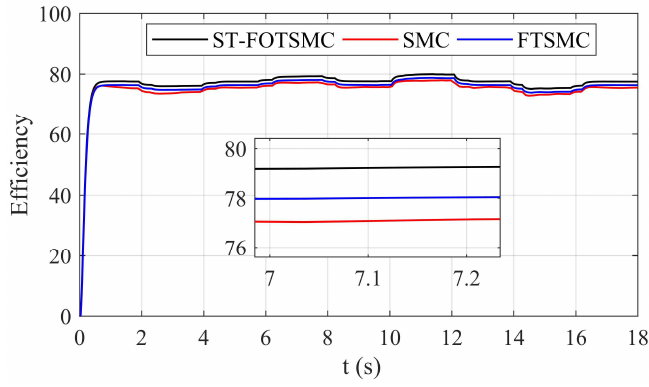
Figure 15. E ffi ciency of the Figure 15. Efficiency of the DFIG.